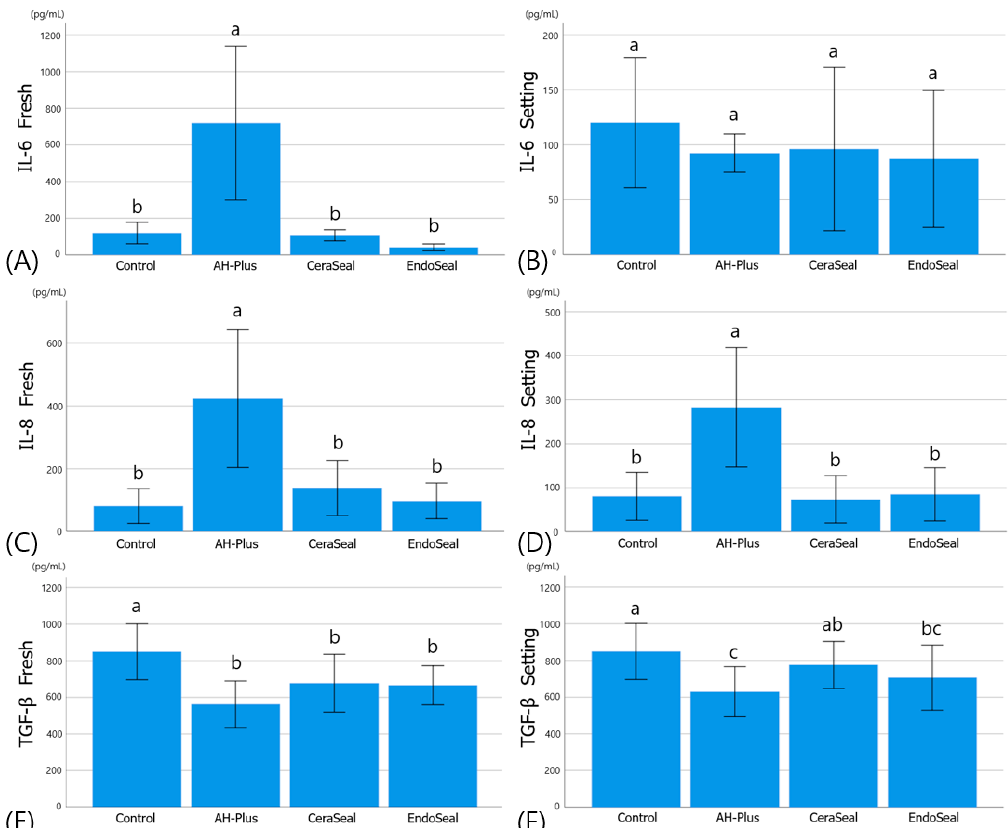
Figure 3. Inflammatory response of hPDLSCs. ( A ) IL-6 expression in fresh media, ( B ) IL-6 expression in setting media, ( C ) IL-8 expression in fresh media, ( D ) IL-8 expression in setting media, ( E ) TGF- β expression in fresh media, and ( F ) TGF- β expression in setting media. Different alphabets indicate that there is a difference between the materials within the same experimental group ( p < 0.05).